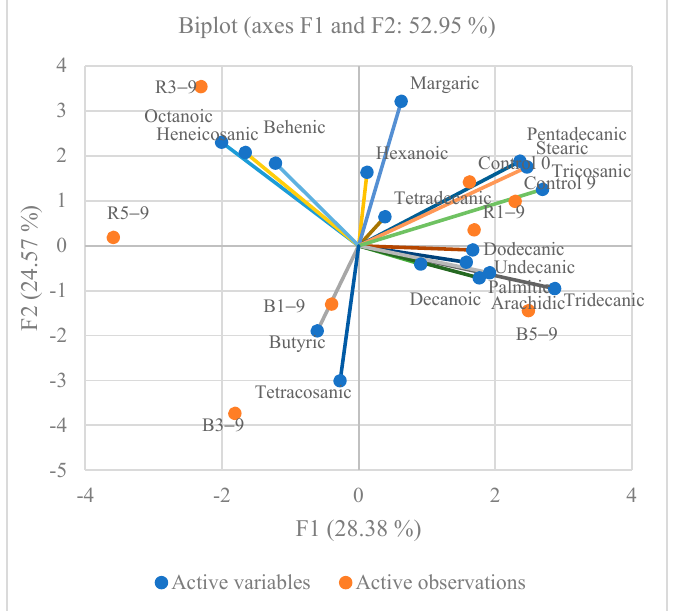
Figure 3. Principal component analysis (PCA) for saturated fatty acids of meat patties with different berries pomace additive stored for nine days (Control 0—meat patties without additives before storage; Control 9—without additives stored for 9 days); R1–9 and B1–9—with 1% of raspberry and blackberry pomace additives after 9 days of storage; R3–9 and B3–9—with 3% of raspberry and blackberry pomace additives after 9 days of storage; R5–9 and B5–9—with 5% of raspberry and blackberry pomace additives after 9 days of storage).